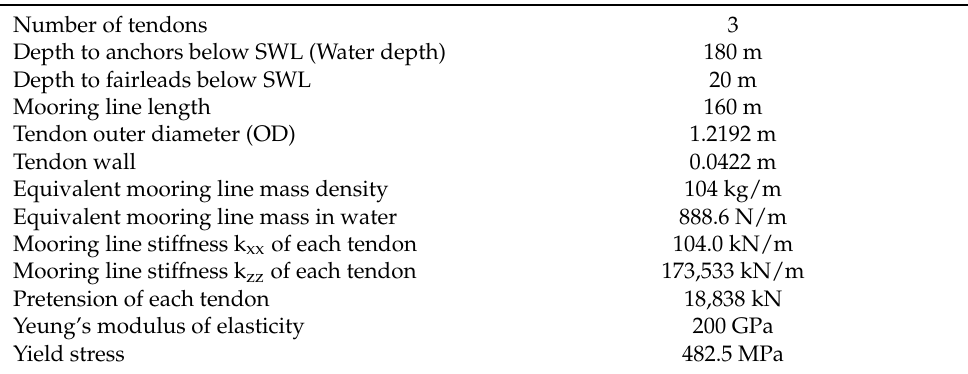
Table 3. Mooring system